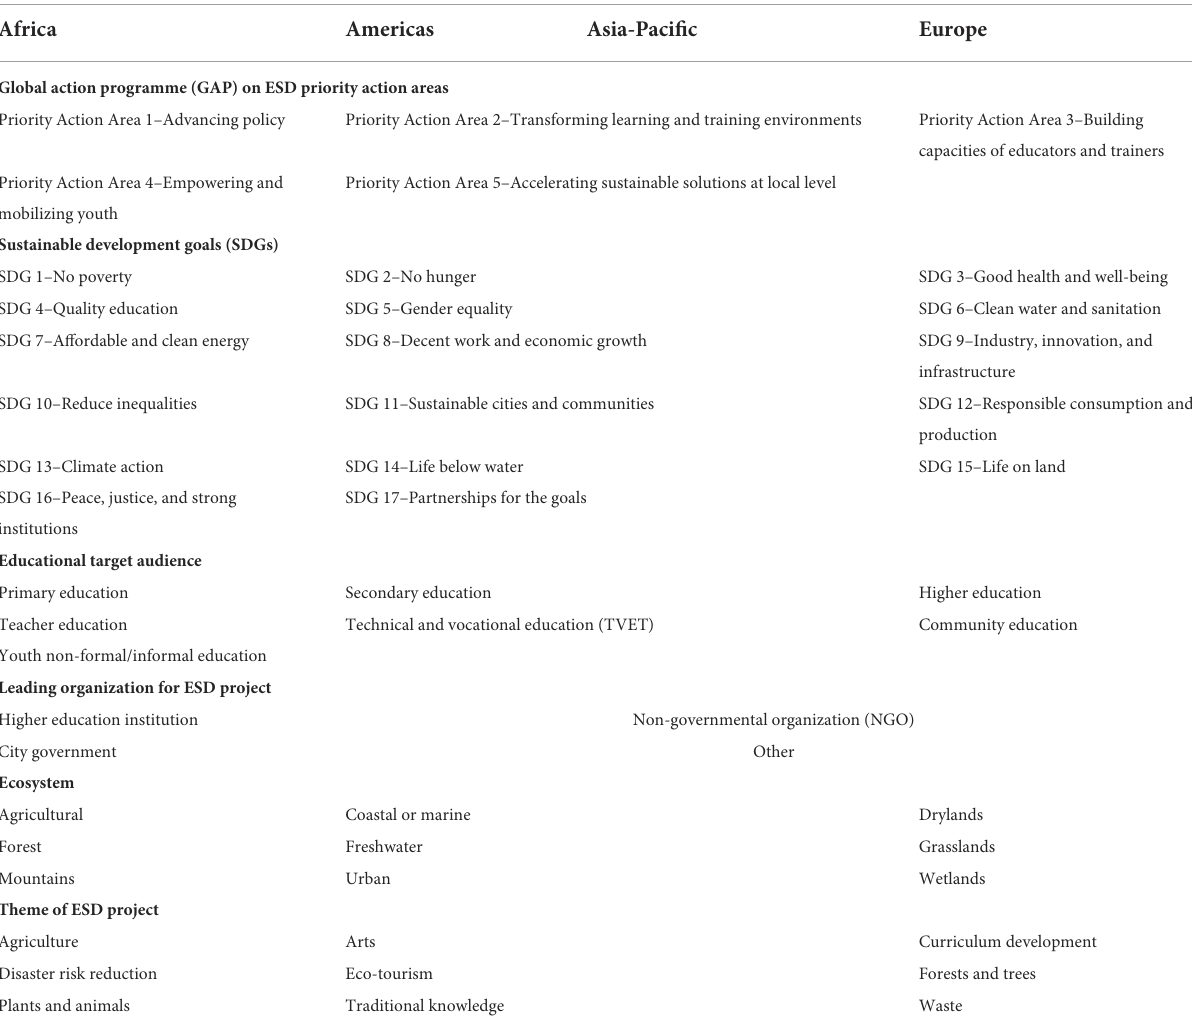
TABLE 1 Data categories and data tags for RCE project report coding.